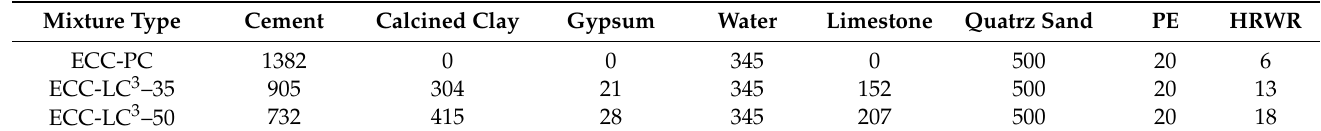
Table 1. Mixture proportion of ECC (kg/m 3 ).